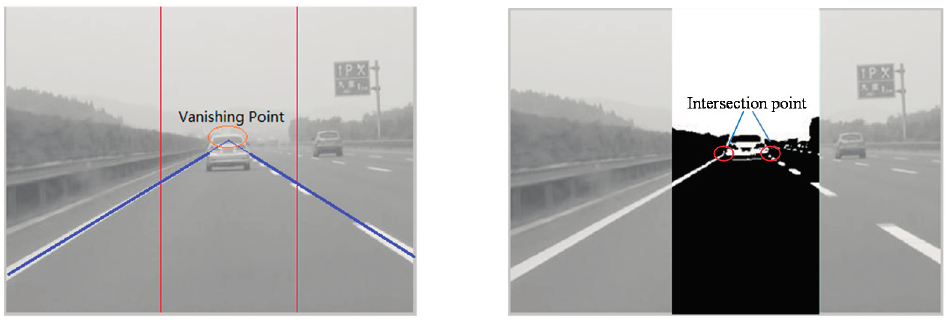
Figure 5. Vanishing point and ROI